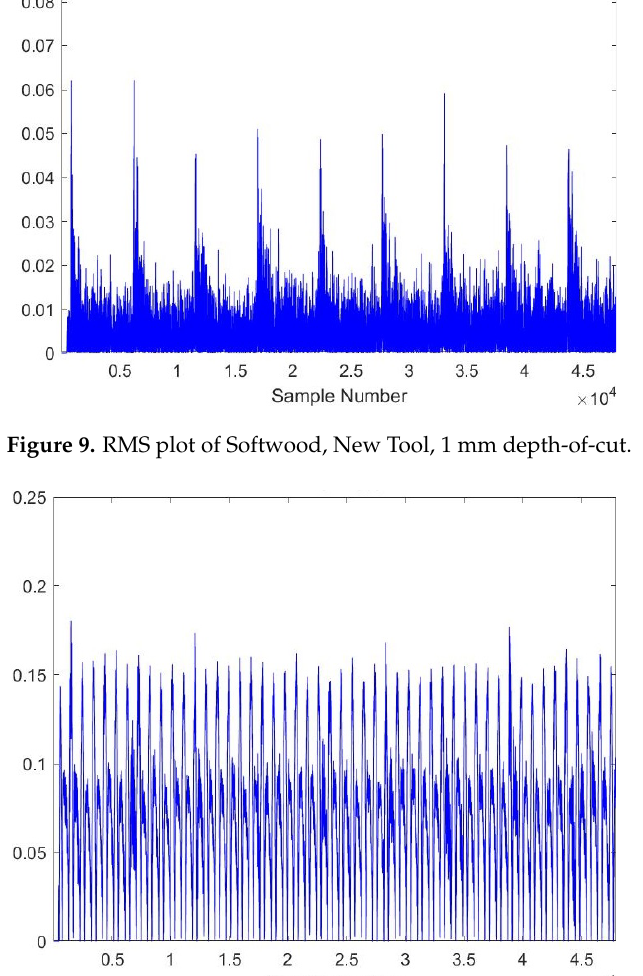
Figure 10. RMS plot of Softwood, Worn-out Tool, 3 mm depth-of-cut.